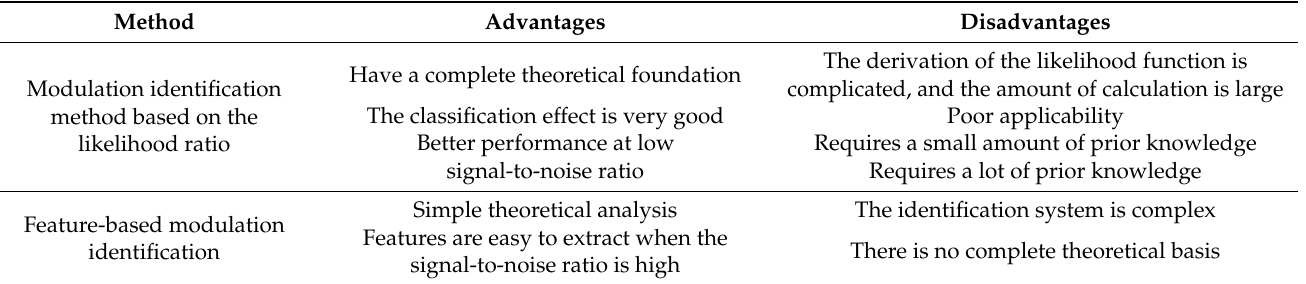
Figure 4. Summary of signal features and classifiers. Table 1. Summary of advantages and disadvantages of traditional methods for automatic modulation